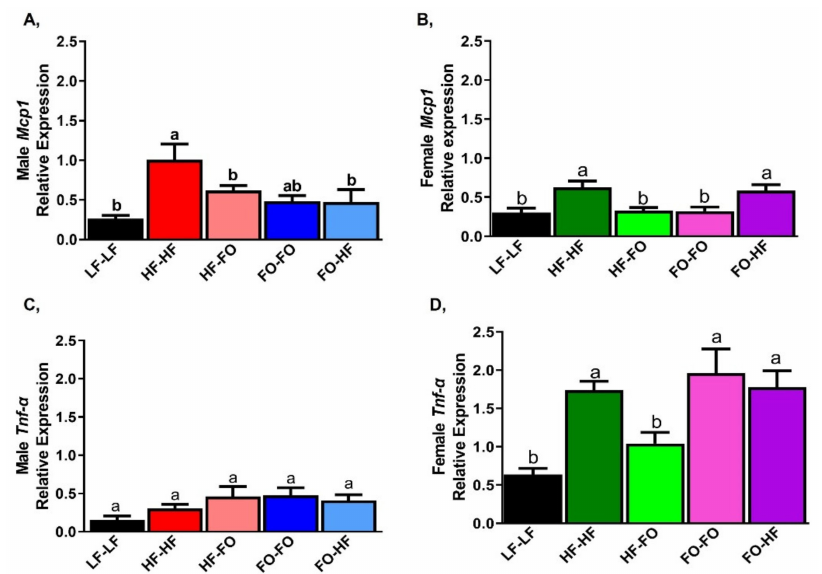
Figure 6. Fish oil supplementation alters pro-inflammatory markers in mice gonadal fat. ( A , B ) mRNA levels of pro-inflammatory marker monocyte chemoattractant protein ( Mcp1 ) in male and female mice. ( C , D ) mRNA levels of pro-inflammatory marker tumor necrosis factor alpha ( Tnf alpha ) in male and female mice. Data is presented as mean ± SEM (n = 8). Common letters on the error bars indicate no significance (e.g., “a” is significantly different from “b” and “ab” indicates no significance compared to “a” and